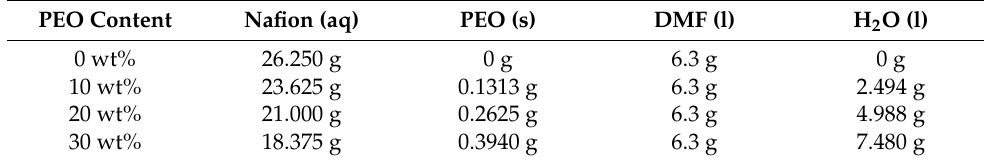
Table 1. Composition of the casting solutions for PEO/Nafion blending